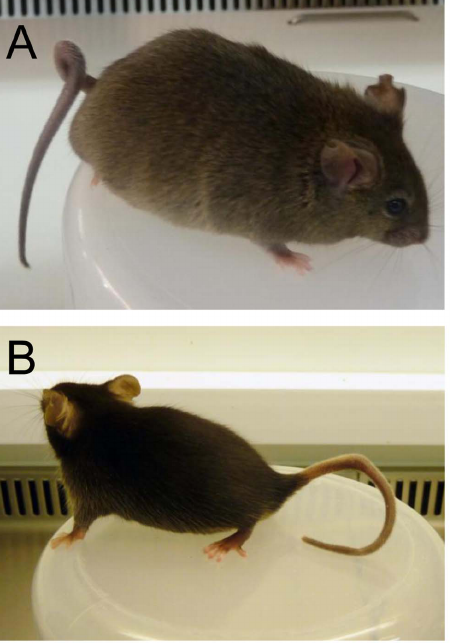
Figure 3. Examples of the curly tail phenotype seen in some of the mutant founder mice. A) TALEN-A C3H founder 10. B) TALEN-B